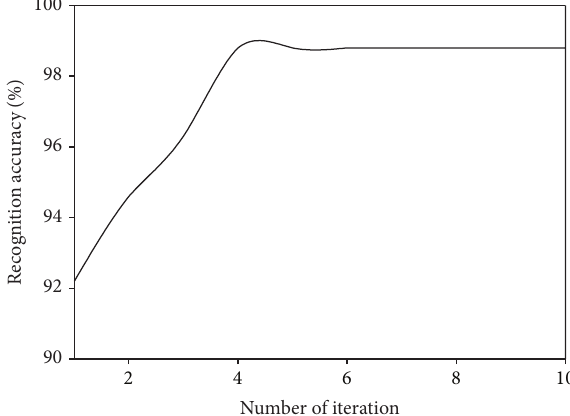
Figure 7: Recognition accuracy of MDGPP versus different num- bers of iteration on the AR